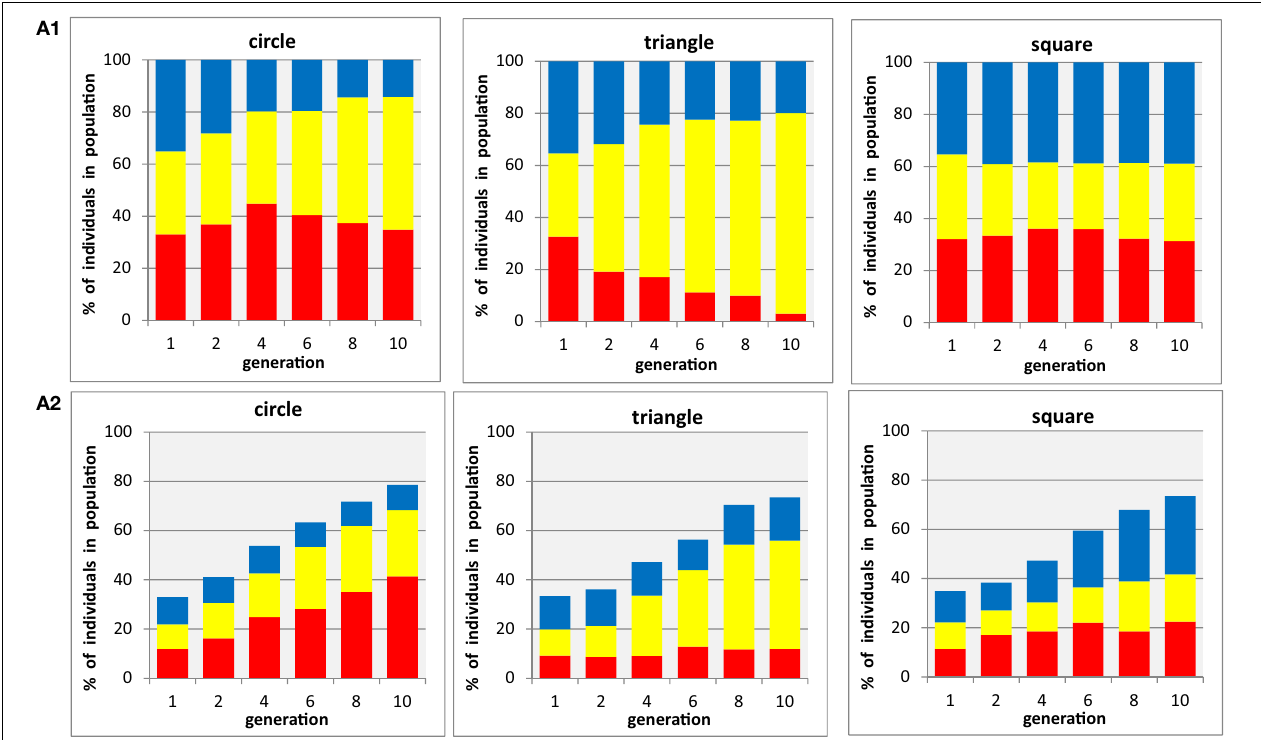
FIGURE 3 | Evolution of populations with three shapes × three colors. (A1) three shapes are tested in separate populations containing a single shape each (i.e., participants are asked to select the preferred individual from three color-shape combinations with identical shape). (A2) three shapes are tested in mixed population containing all shapes (i.e., participants select the preferred color-shape combination of a given shape in the presence of both other shapes, combined with the same three